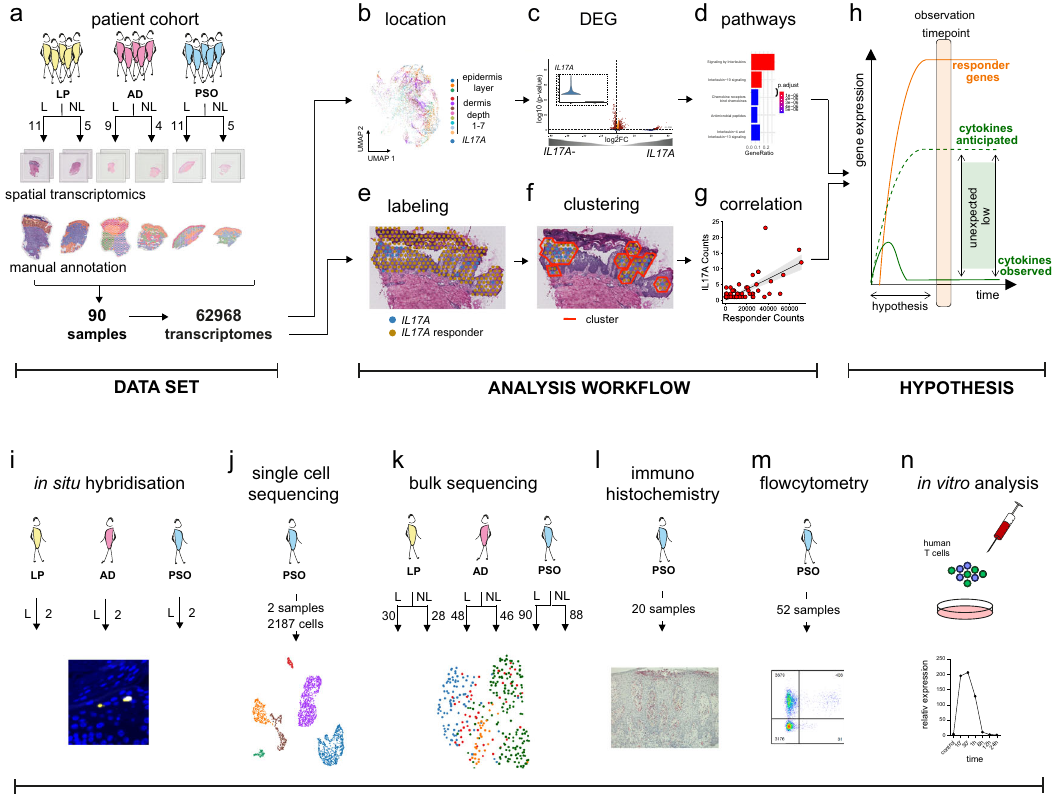
Fig. 1 | The study design highlighting the spatial transcriptomic dataset, the analysis pipeline, and the validation cohorts and techniques. a ST dataset consisting of 90 spatial samples (31 patients) 62 lesional samples, 28 non-lesional samples, and three ncISD (lichen planus (LP), atopic dermatitis (AD), psoriasis (Pso)) resulting in 62,968 transcriptomes. Within the analysiswork fl ow, everyspot in all samples was manually annotated according to tissue localization (basal-, middle-, upper epidermis, dermis depth 1-7). b Leukocyte-positive spots were de fi nedbytheexpressionofeither CD2,CD3D,CD3E,CD3G,CD247(CD3Z),orPTPRC (CD45) or combinations of markers and cytokine transcript-positive leukocytes wereassignedtoatissue localization. c Differentialgeneexpression (DEG)analysis